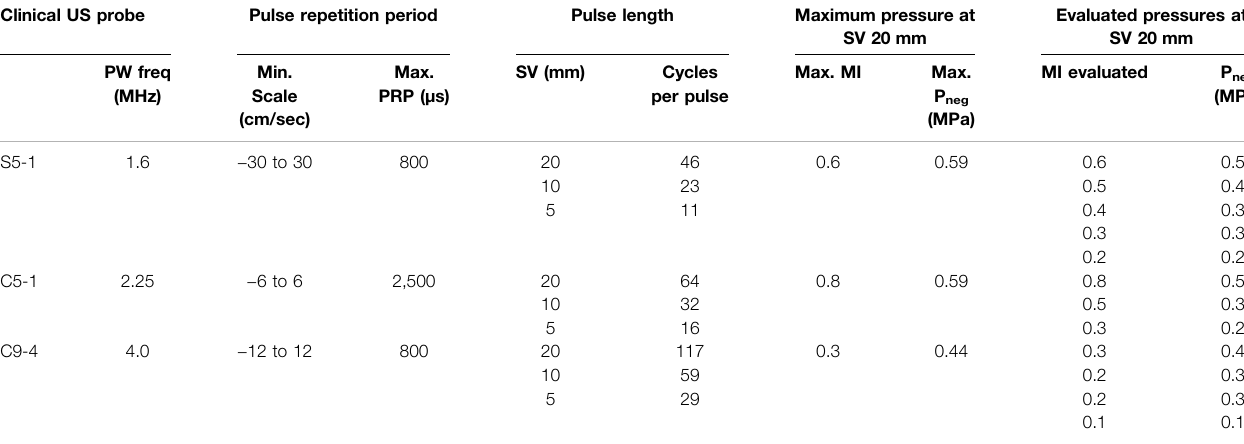
TABLE 1 | US parameters and corresponding measurements on clinical US system. Clinical US